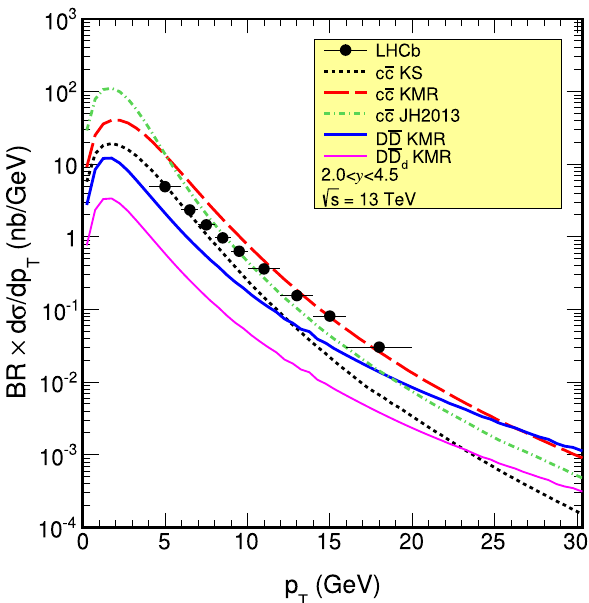
Fig. 5 Transverse momentum distribution of X ( 3872 ) for the LHCb experiment. Shown are results for 3 different gluon uPDFs. Here BR = 0.038. The upper limit for the SPS molecular scenario is shown as the thick solid line. The thin solid line shows the molecular scenario neglecting the feeddown component of D 0 , ¯ D 0